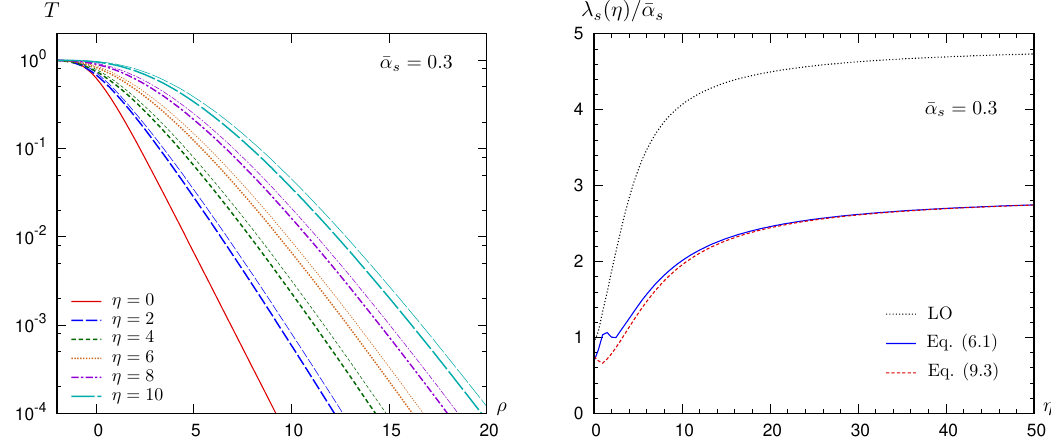
r undergoes a (cid:28)